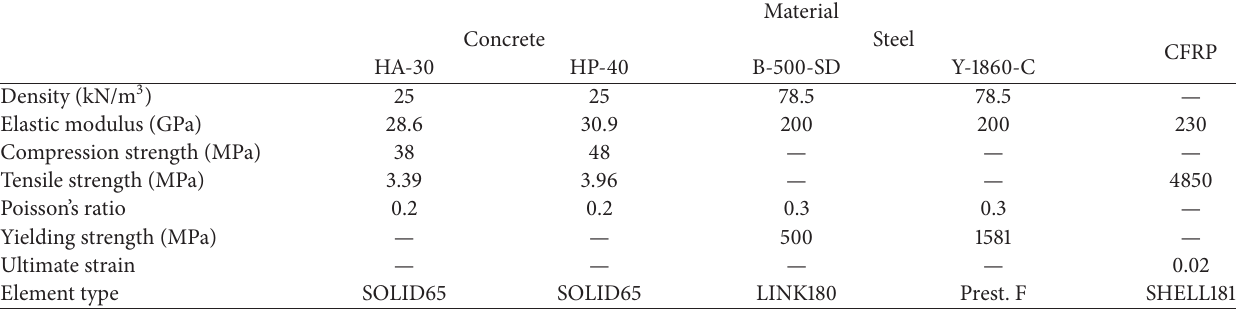
Table 2: Mechanical properties of